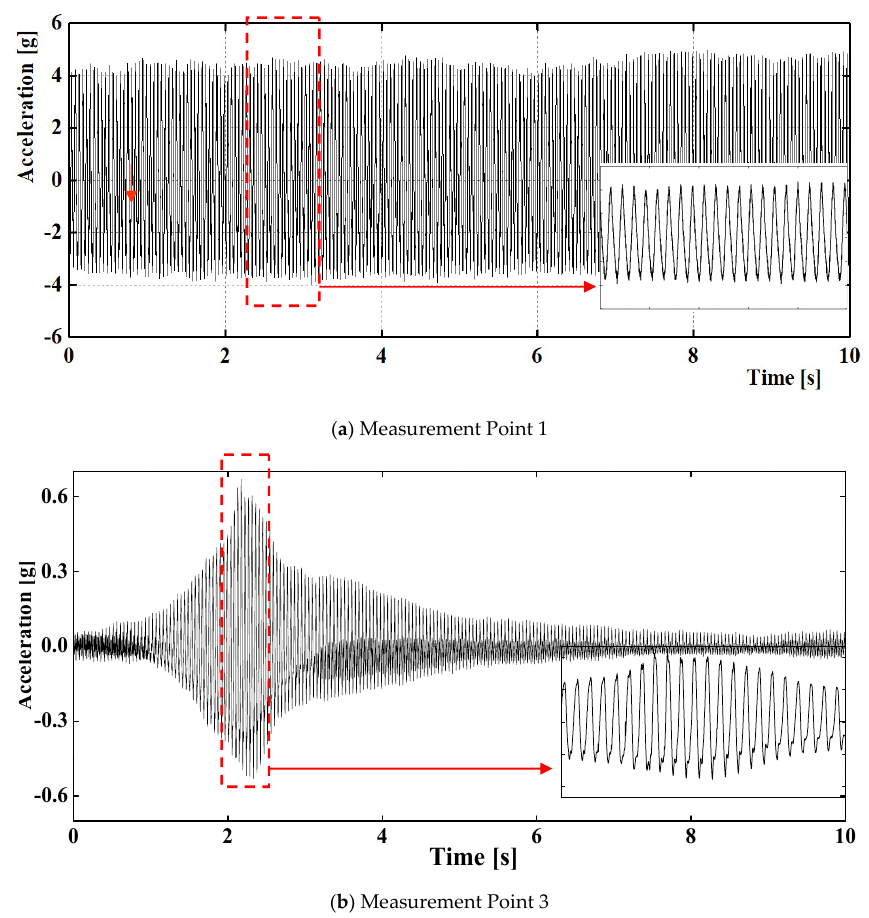
Figure 5. Acceleration time-history curves.